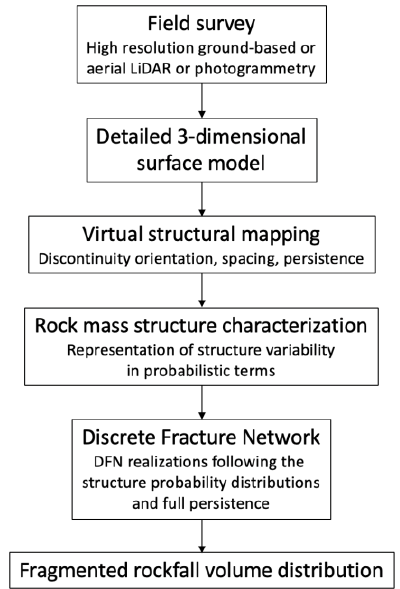
Figure 1. Method for calculating fragmented rockfall volume distribution from remote sensing, virtual structural mapping and discrete fracture networks.